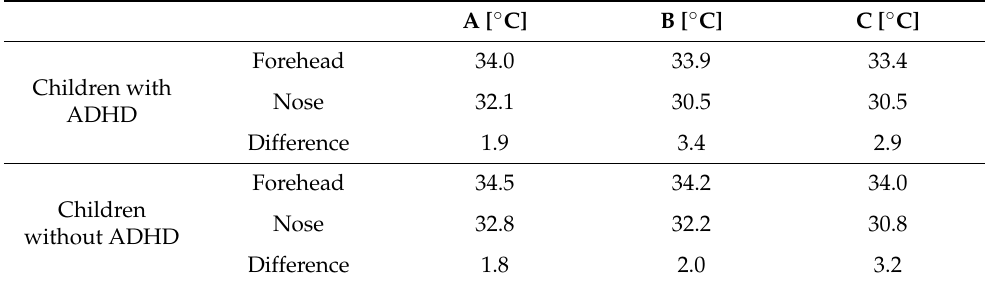
Table 4. Average values of nose and forehead temperatures for children with and without ADHD in all three seats. The seats are marked as A—active seat, B—therapy ball and C—school